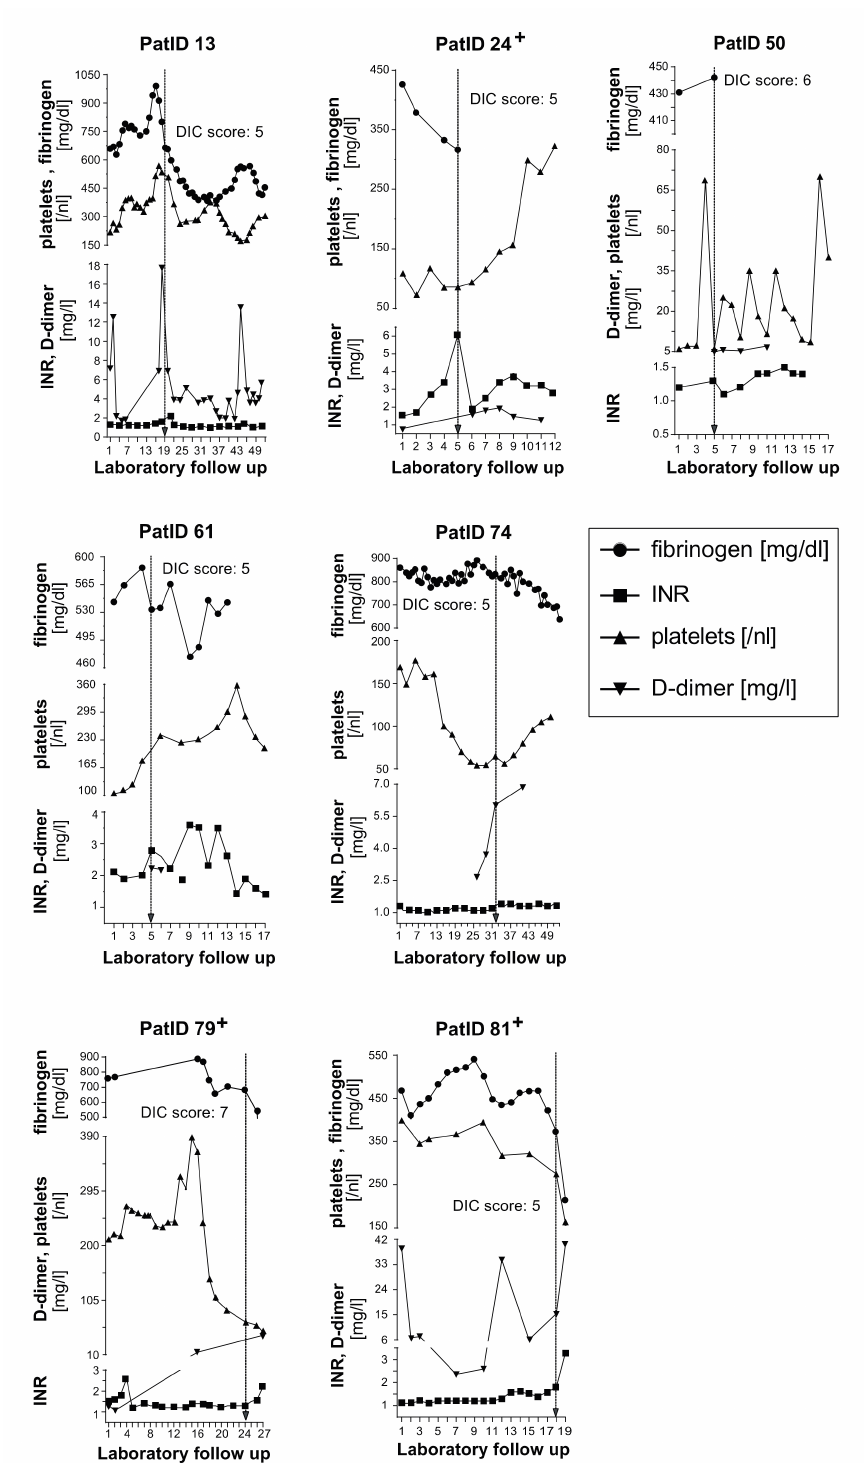
Figure 2. Time course of fibrinogen, INR, platelet count and D-dimer values in seven patients who developed DIC during COVID-19. The engraved arrow indicates the time of DIC manifes- tation as defined by the corresponding DIC score. Three patients with DIC died as indicated (+). DIC, disseminated intravascular coagulation; INR, international normalized ratio; PatID, patient identification